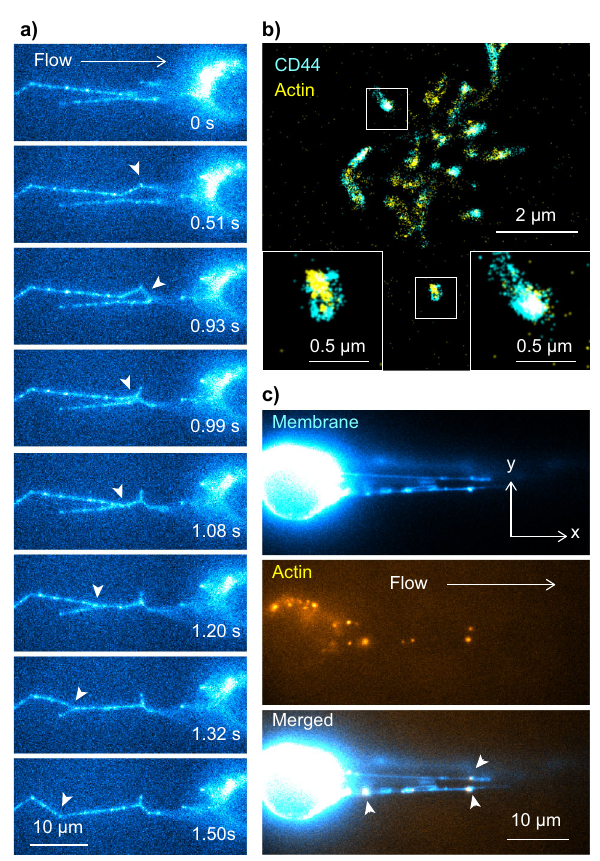
Fig. 8 Detachment of cell membrane from actin cytoskeleton during the tether formation. a Time-lapse fl uorescence images of the PSGL-1 molecule (immunostained by Alexa-Fluor-555-conjugated anti-PSGL-1 antibody) on the KG1a cell captured during cell rolling over E-selectin, which show the merger of the multiple tethers. The white arrowheads show the regions in which the merger of the tethers occurs. b Two-color super- resolution fl uorescence localization microscopy image of CD44 (cyan, immunostained by anti-CD44 515 antibody followed by Alexa-Fluor-647- conjugated secondary antibodies) and actin (yellow, labeled by Alexa- Fluor-488-conjugated phalloidin) on the control KG1a cell. The insets show enlarged views of the yellow regions. c Two-color fl uorescence images of the cell membrane (cyan, stained by Vybrant DiO dye) and actin (yellow, labeled by silicon-rhodamine-conjugated jasplakinolide) on the slings of the KG1a cells formed during cell rolling over E-selectin. The white arrowheads show the regions in which the patches of actin colocalize with the slings. All the fl uorescence images of the rolling cells were captured by injecting KG1a cells into the micro fl uidic chambers at a shear stress of 2 dyne cm − 2 (0.2 Pa) whose surface was coated by the rh E-selectin at a density of 15 molecules µ m − 2 Preparation and functionalization of the micro fl uidic chambers . Commercially available micro fl uidic chambers, μ -slide VI 0.1 uncoated (1 mm width and 100 µm height, ibidi GmbH) were used for in vitro cell rolling assay. We calculated applied shear force ( τ ) using the following equation, τ = 6 µQ / a 2 b , where a and b are the height and width of the chamber and µ and Q are the viscosity of the medium and volumetric fl ow rate. Recombinant homodimeric human (rh) E-selectins (Sino